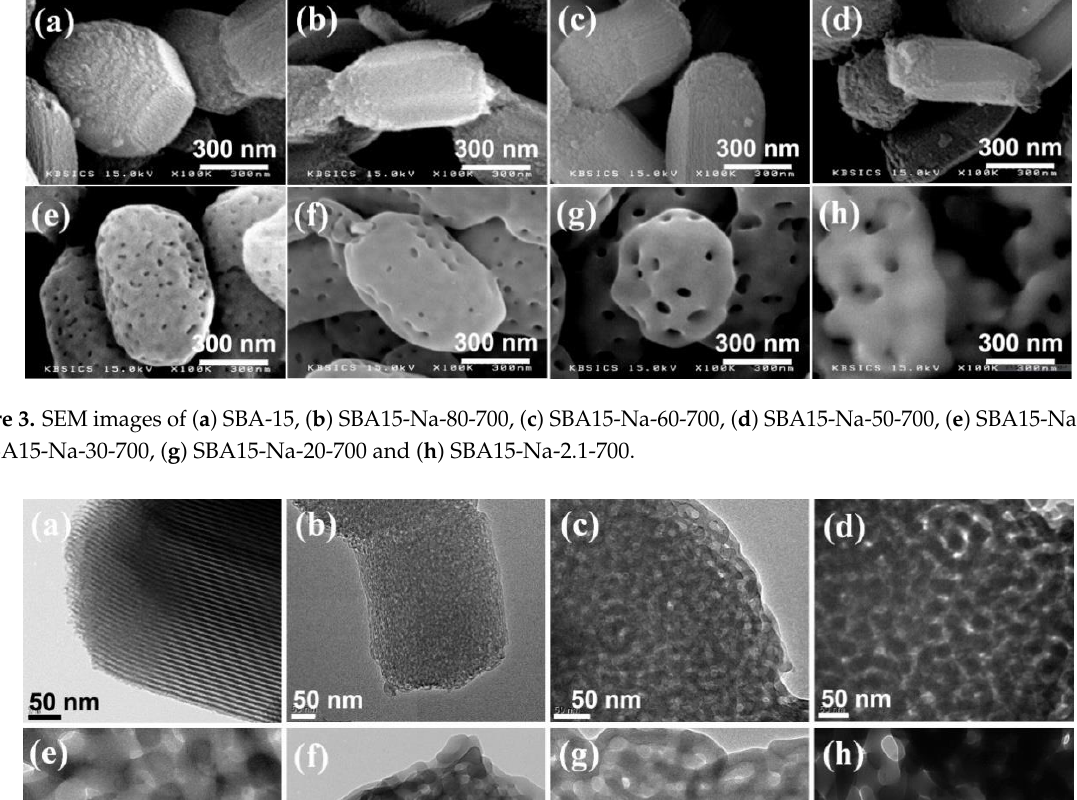
Figure 3. SEM images of ( a ) SBA-15, ( b ) SBA15-Na-80-700, ( c ) SBA15-Na-60-700, ( d ) SBA15-Na-50-